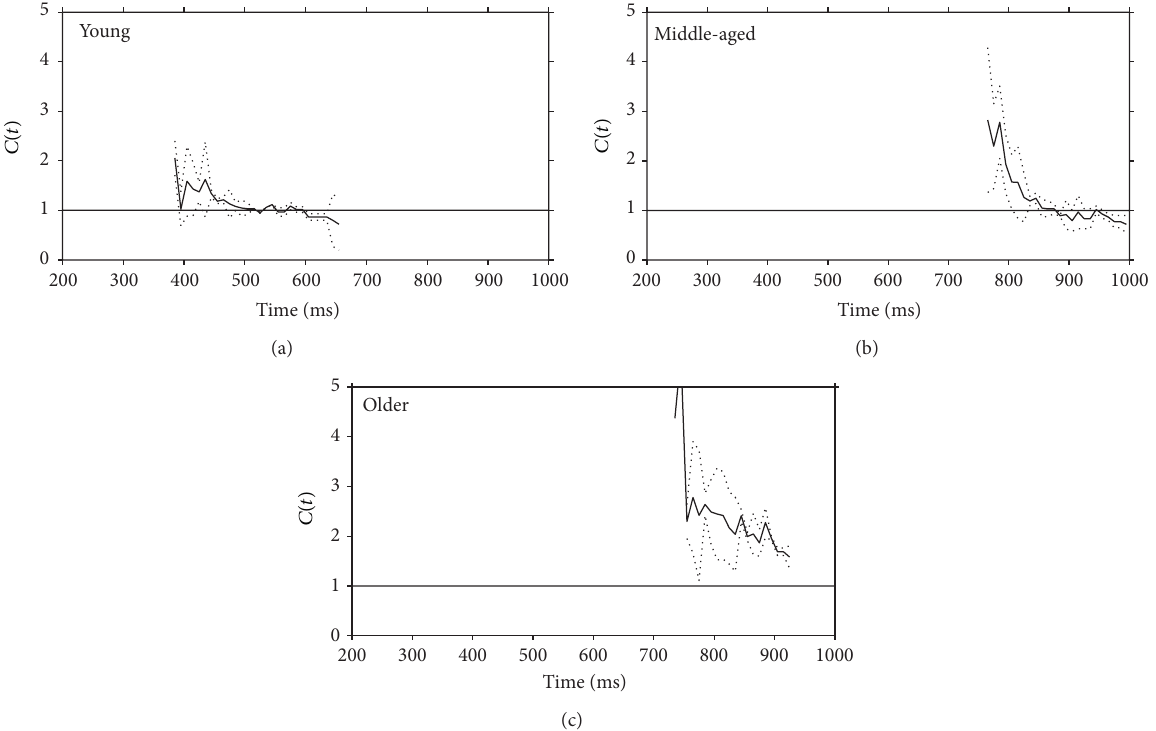
Figure 6: Capacity coefficients for the three groups of participants: top row young adult and middle row middle-aged people. The horizontal line at 𝐶(𝑡) = 1 indicates the reference value for unlimited capacity. The capacity coefficients are depicted in solid line; the confident interval for capacity coefficient is depicted in dash